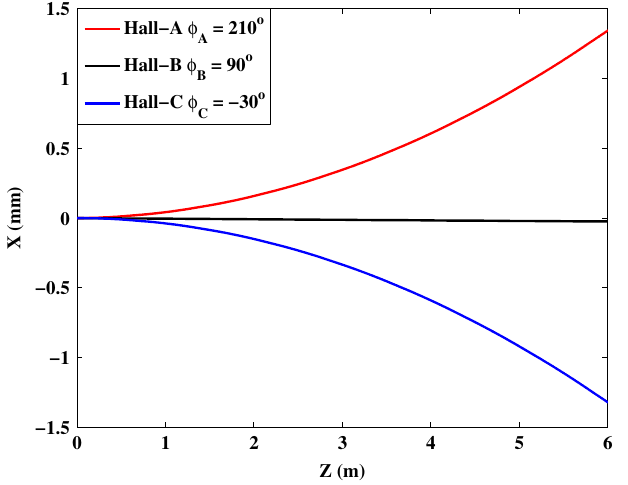
FIG. 18. Vertical displacement for an 11 GeV electron corre- sponding to the transverse displacements of 3 and 5 mm for rf phases (cid:4) A;B;C . The legend corresponding to ‘‘0 mm’’ refers to perfect alignment.